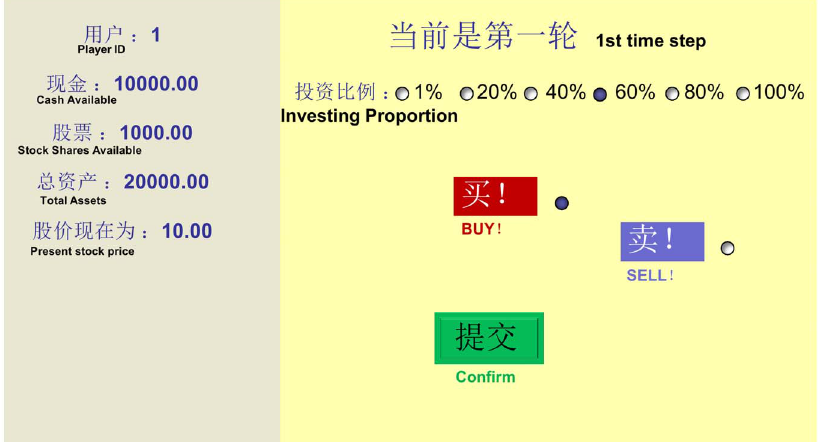
Figure 1. The information and operational panel of the experiments. It is in both English and Chinese. The left part is the information panel of the stock and the player, showing the financial status of both the stock and the player at each time step; and right part is the operational panel of buying and selling. With all these information that would be updated at each time step during the experiments, the players could have an overall understanding of the current situation and their historical performance, and then make their own trading decisions.